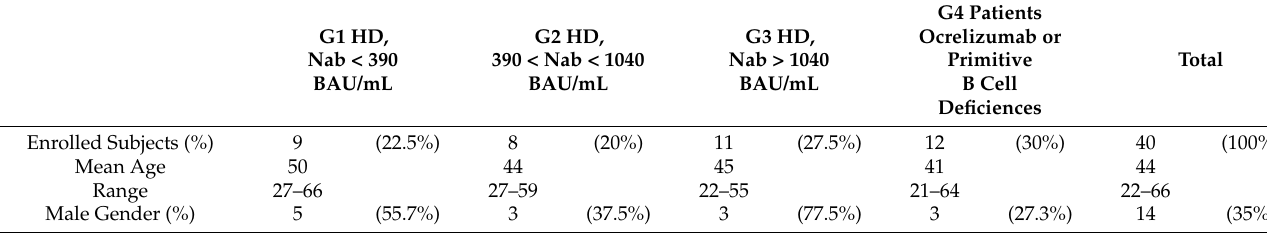
Table 1. Characteristics of enrolled